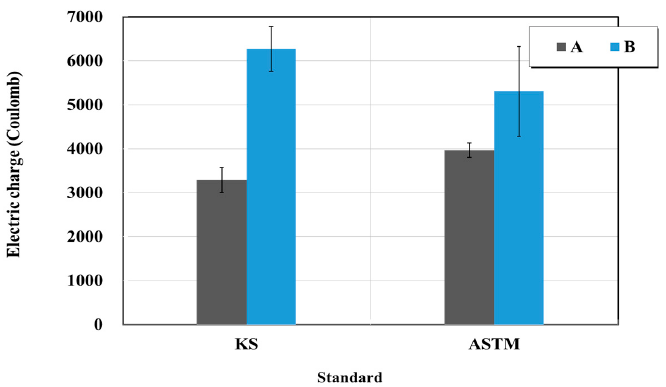
Figure 13. Results of electric charge test for resistance to chloride ion penetration obtained based on the KS and ASTM standards.